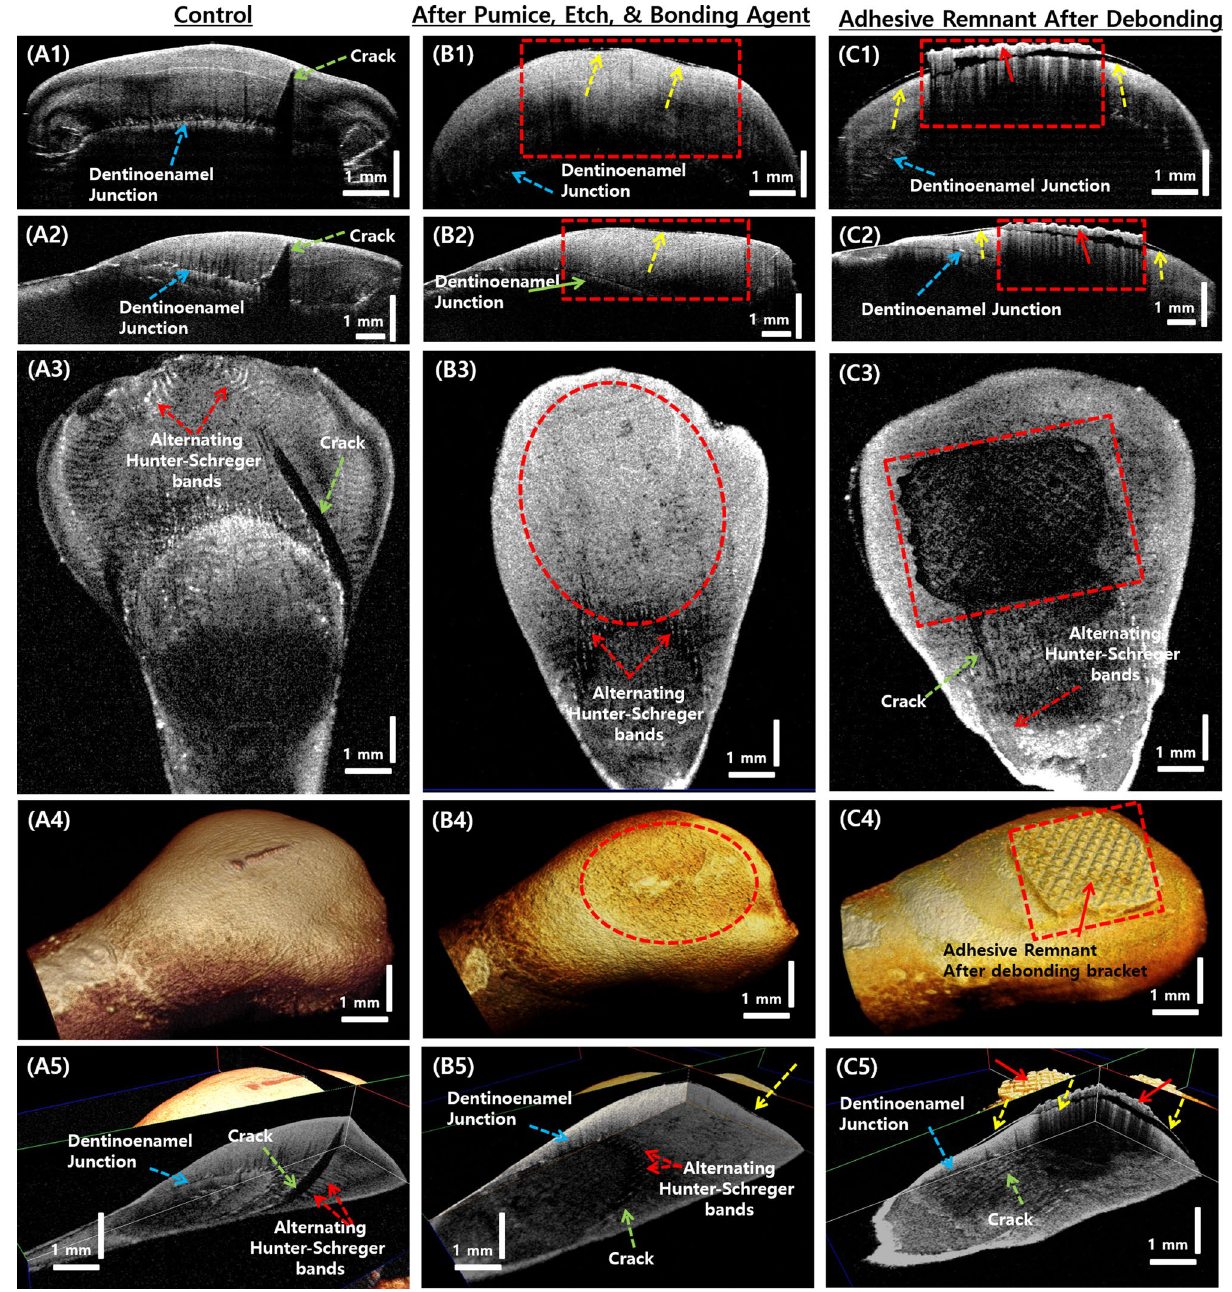
Figure 5. 2D and 3D OCT images of tooth samples that underwent control, etch, and pumice followed by etching and bonding agent procedures. ( A1 – A5 ) are the control sample OCT images, ( B1 – B5 ) are the OCT images of a tooth sample that underwent pumice, etching and bonding agent application, and ( C1–C5 ) are the 2D and 3D OCT images of a tooth sample after bracket debonding with the presence of adhesive remnant. Regions within the rectangular and circular dashed areas indicate the parts of the tooth surface that underwent the treatment tooth after two attachments and removals, the overall enamel content and enamel abrasion is further increased. This can be observed in the cross-sectional images in the axial and sagittal planes as shown in C1 and C2, in the en face image 500 µ m below the external tooth surface as shown in B3, and also in B4 and B5, which are the 3D volumetric image and the volumetric OCT image with all three sectional planes showing the internal morphol- ogy of the sample. It can also be seen that the visibility of the dentinoenamel junction is reduced in the sample after debonding and adhesive cleaning.